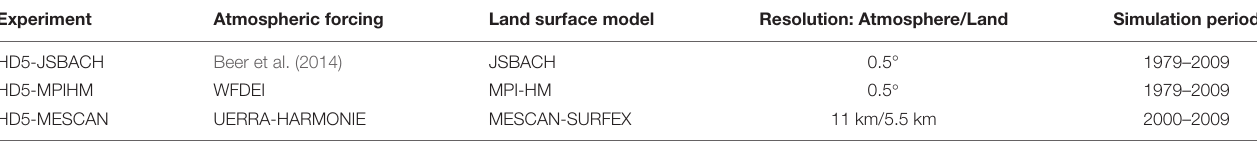
TABLE 1 | Model experiments and their forcing